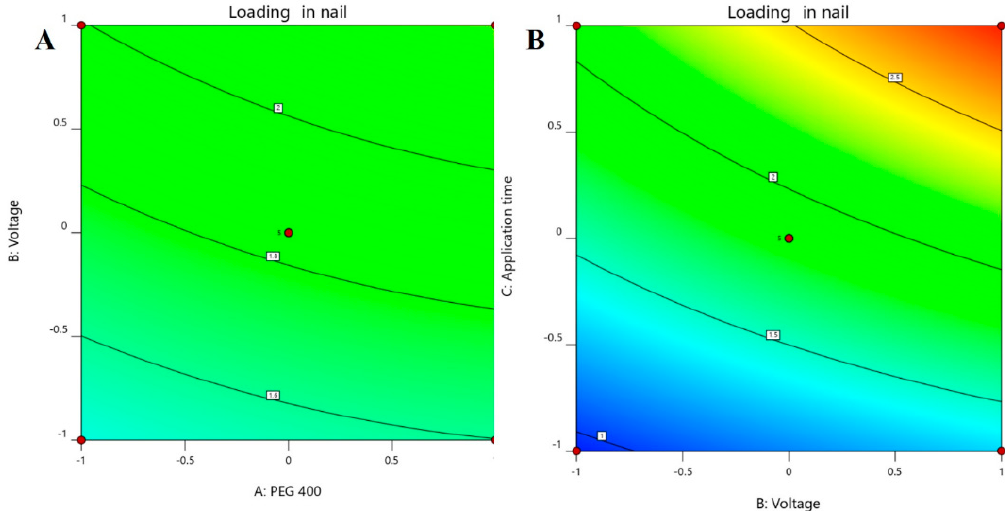
Figure 6. Contour plot response showing the effect of independent variables on the permeation of drug ( A ) voltage versus PEG 400 and ( B ) application time versus voltage.